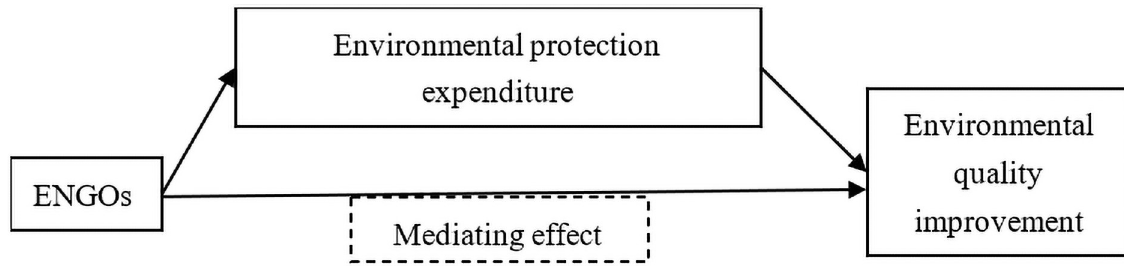
Fig 1. Impact mechanism of ENGOs on environmental quality